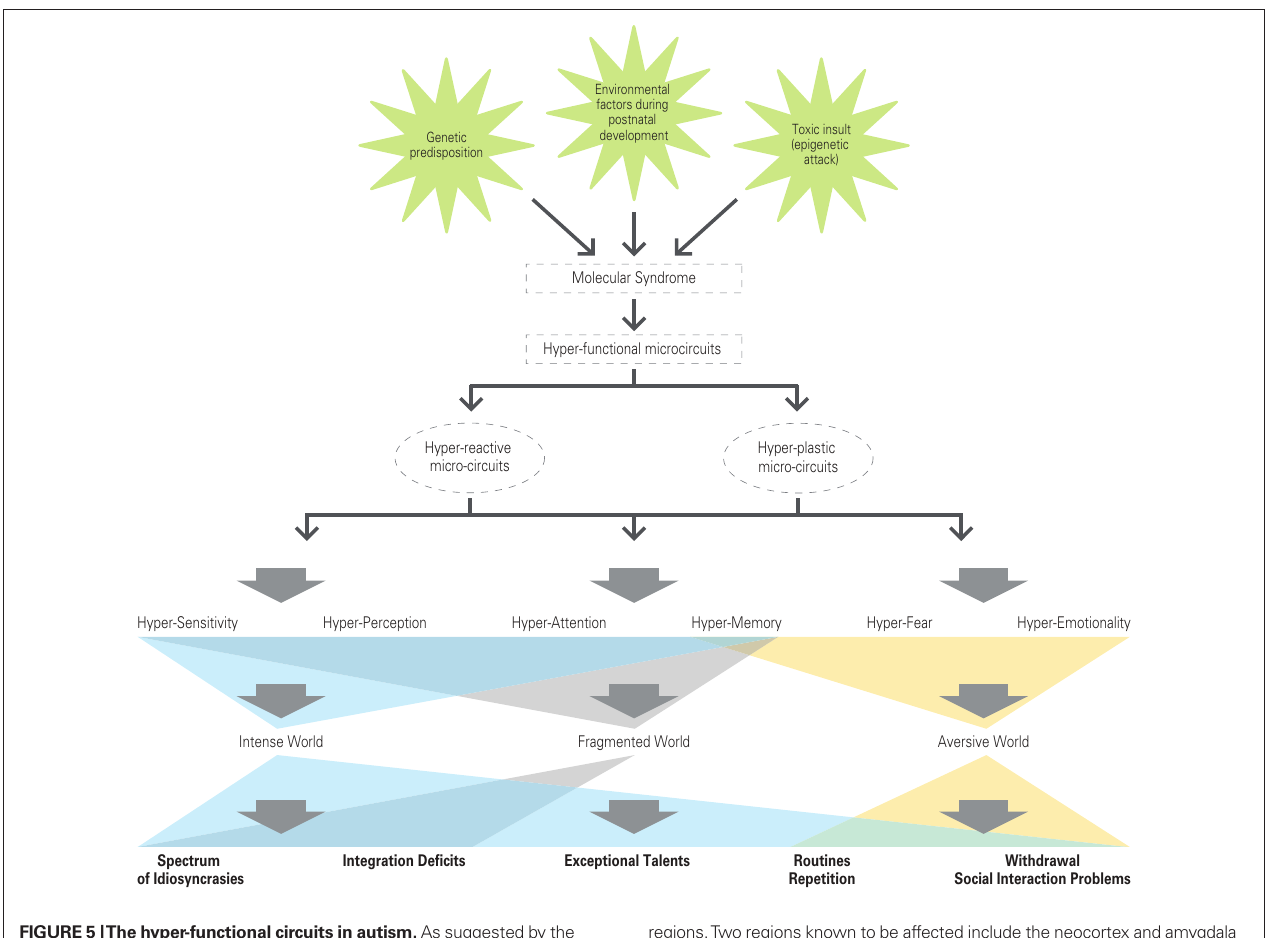
Figure 5 | The hyper-functional circuits in autism. As suggested by the Intense World Theory three etiological factors (a genetic predisposition; an epigenetics attack in form of a toxic insult; environmental factors during postnatal development) cause autism by activating a molecular syndrome that may be different across different brain regions, but that leads to hyper-functional microcircuits (expressed as hyper-reactivity and hyper-plasticity) in all brain